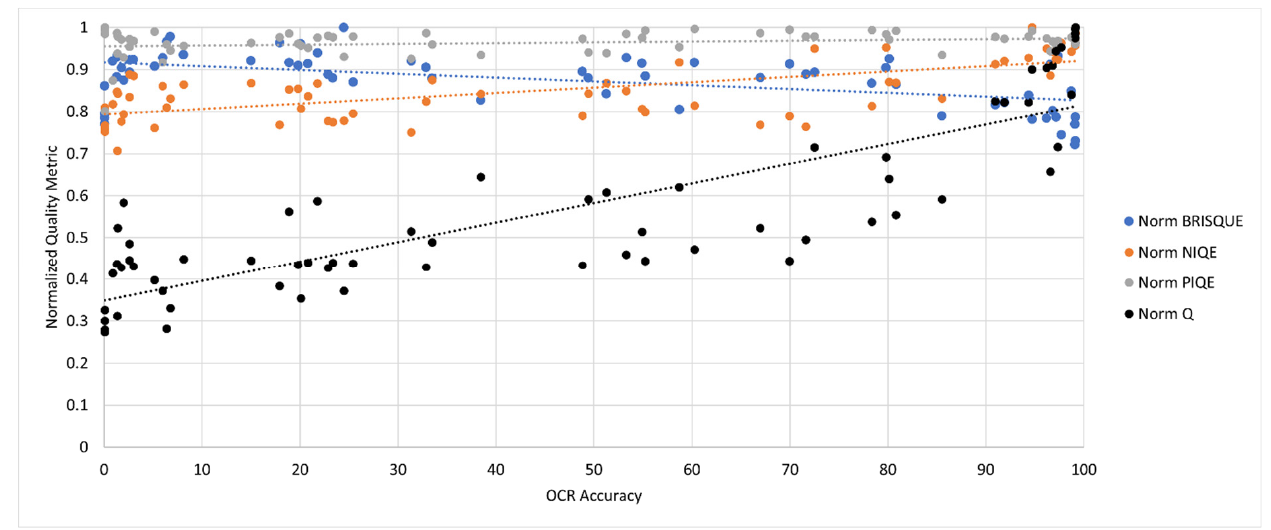
Figure 10. Normalized NR-IQAs vs. OCR Accuracy for document D1 of the SmartDoc dataset.